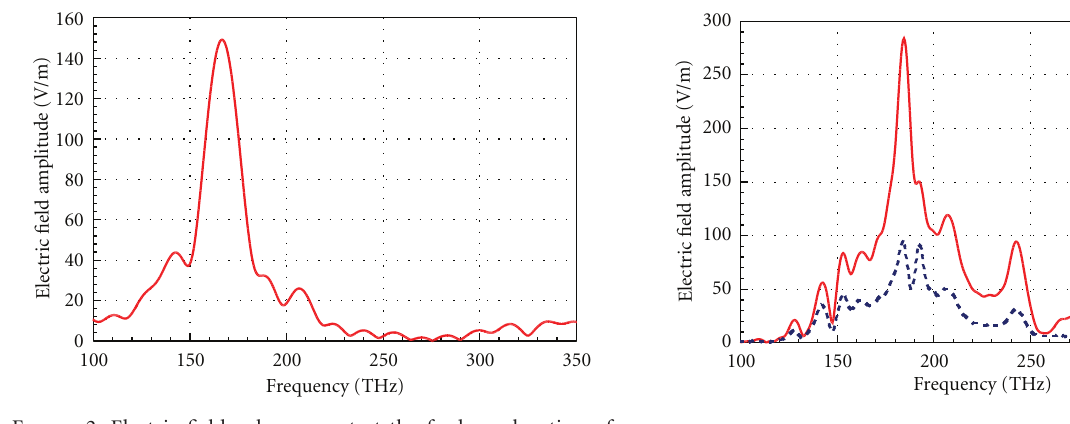
Figure 2: Electric field enhancement at the feed gap location of dipole antenna for x -polarized unity strength plane wave illumina- tion.